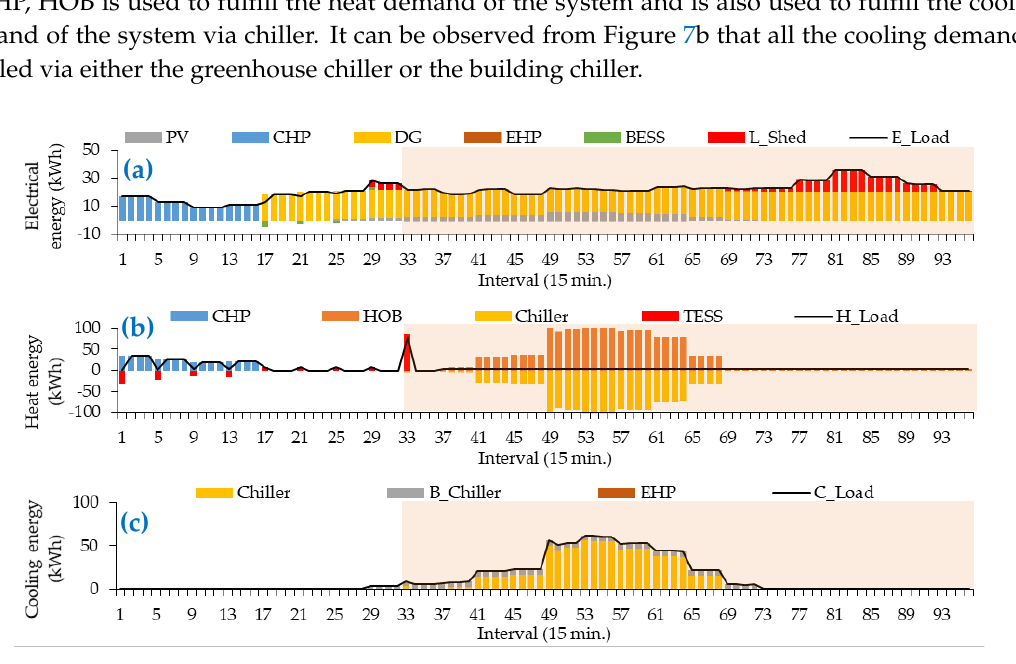
Figure 9. Energy balancing: ( a ) Electrical Energy; ( b ) Heat Energy; ( c ) Cooling Energy.